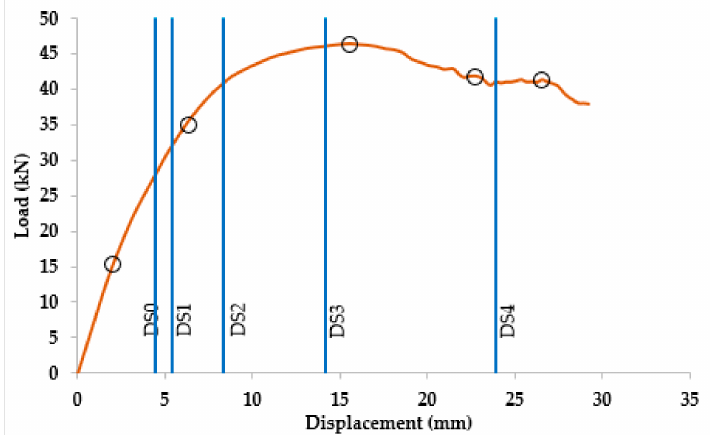
Figure 9. Damage limit state according to Equation (1).